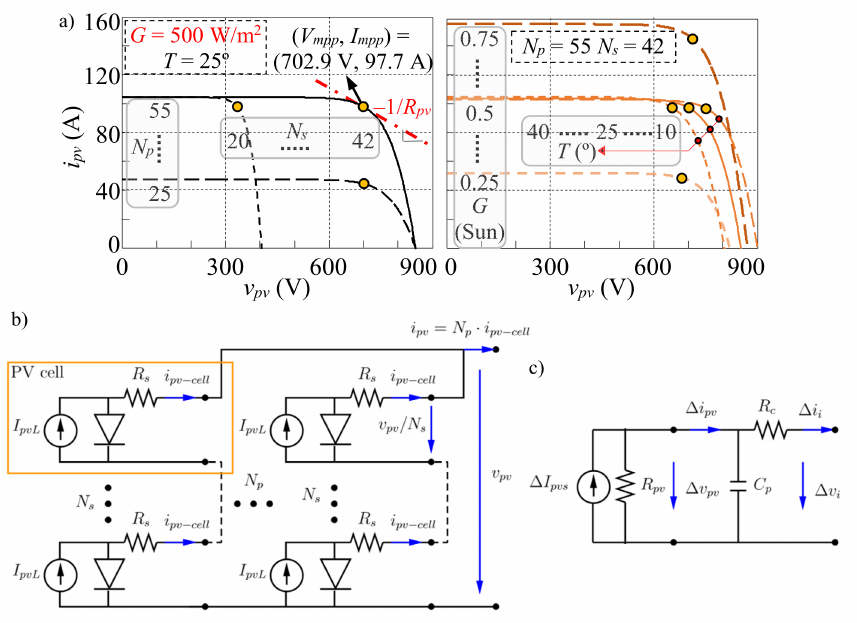
Figure 2. PV installation: ( a ) I-V plot of the PV panel; ( b ) equivalent circuit of the PV panel; ( c ) small- signal equivalent circuit of the PV